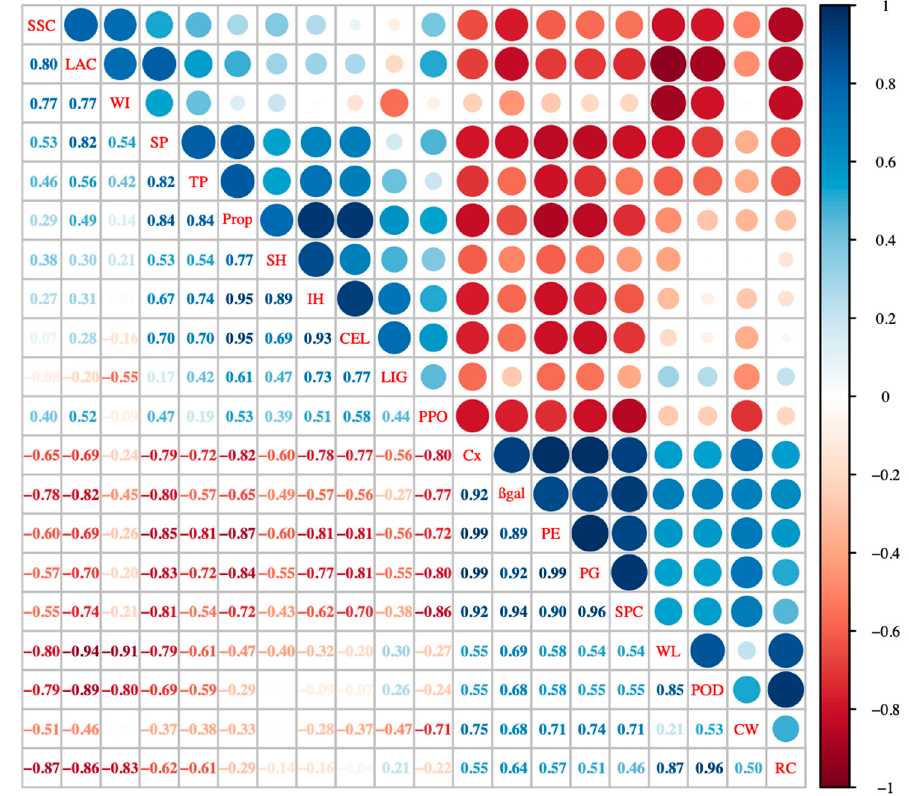
Figure 5. Pearson’s correlation matrix between texture index, cell wall components and relative enzymes. The correlation coefficients are proportional to the magnitude of the value and the intensity of the color. Blue indicates positive correlation, and negative correlation is shown in red ( p < 0.01). ( n = 3). RS, reducing sugar content; TTS, soluble solid content; SPC, soluble pectin; SP, soluble protein; PPO, polyphenol oxidase; PROP; protopectin; β -gal, β -half lactosidase; SH, surface hardness; IH, internal hardness; WL, weight loss rate; RC, relative conductivity; POD, peroxidase; LAC, laccase activity; WI, whiteness value; CEL, cellulose content; LIG, lignin content; Cx, cellulase; CW, cell wall content; PME, pectin methyl esterase; PG, polygalacturonase; TP, total polyphenol content.